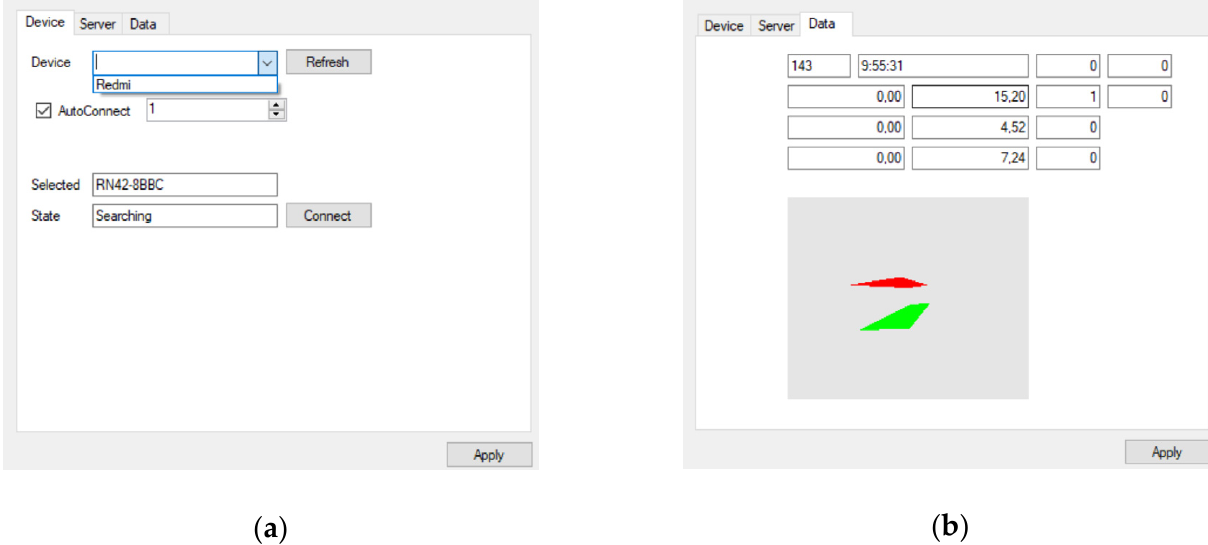
Figure 6. ( a ) Tab that provides the user with a list of available devices. ( b ) Tab that provides the user with data obtained from service.